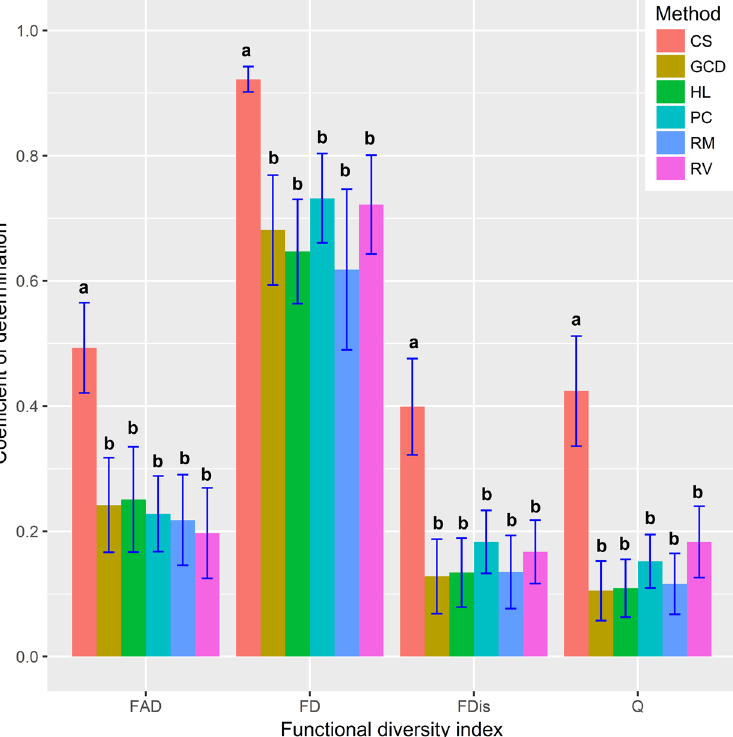
Figure 1. The average closeness of associations between species richness and functional diversity obtained by different methods across four functional diversity indices, FAD, FD, Q, and FDis and six ecosystems. For the CS method, the average was calculated using the highest closeness in each ecosystem. The blue lines indicate ± 1standard error. The different letters above the bars of one functional diversity indices indicate significant difference at the level of